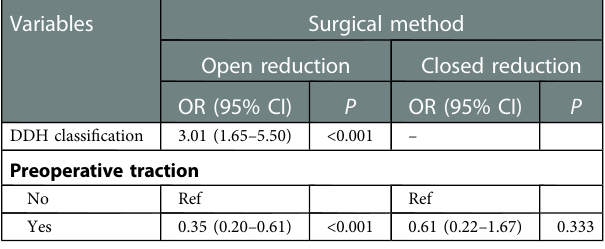
TABLE 6 Association of DDH classi fi cation and preoperative traction with postoperative ANFH in surgical method subgroups.